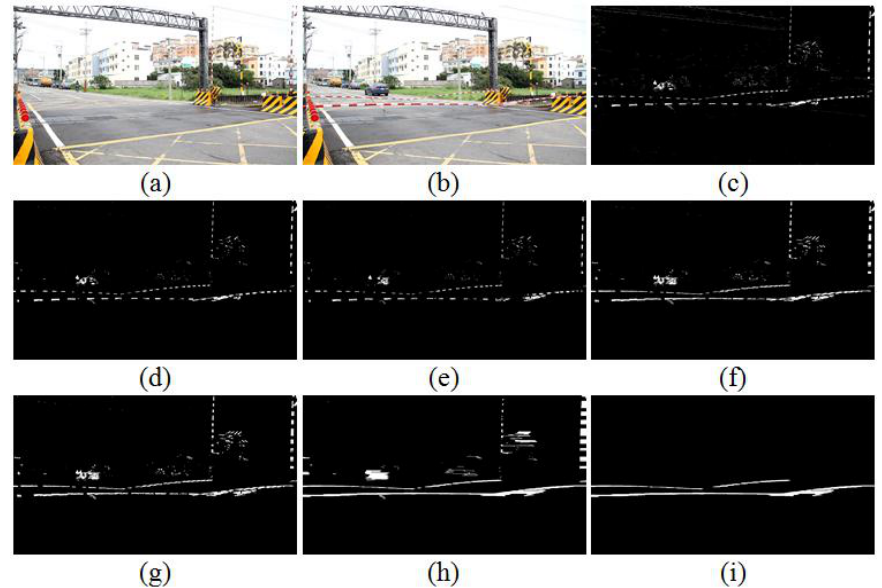
Figure 15. The gates extraction case-2, the railway crossing of NanSikon Road: ( a ) the background image; ( b ) input test image; ( c ) the image after extracting the white part; ( d ) the mage after filtering the noise; ( e ) white part rotation right of (d); ( f ) the image after merging (d) and (e); ( g ) the image after dilation operation; ( h ) the image after the closing operation; ( i ) the image after lengthy fitting operations.